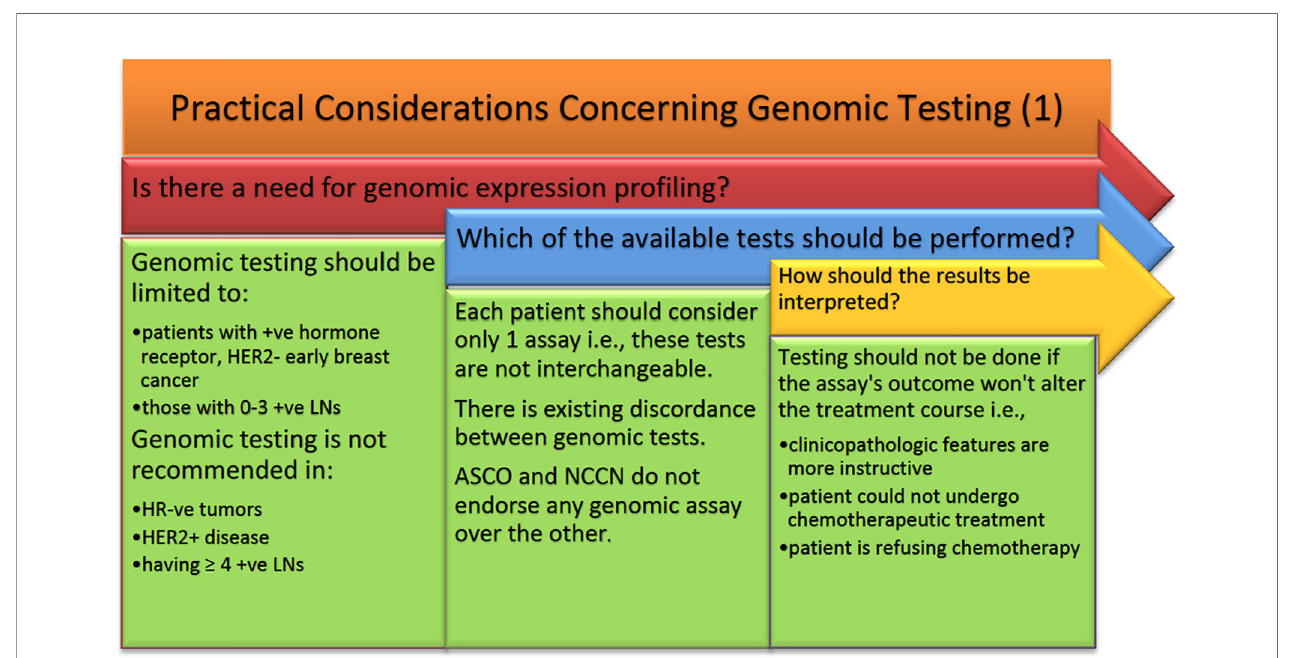
FIGURE 1 | ASCO, American Society of Clinical Oncology; HER2, human epidermal growth factor receptor 2; NCCN, National Comprehensive Cancer